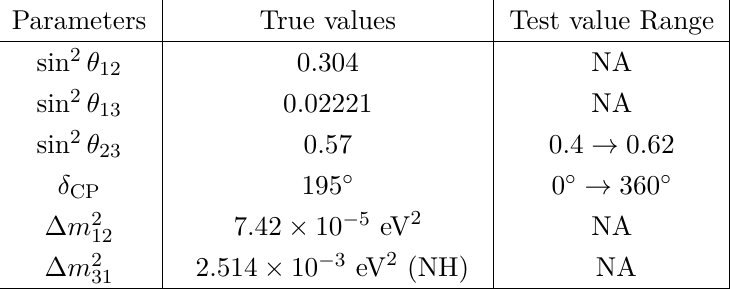
Table 2 . The values of oscillation parameters that we considered in our analysis. values of θ are adopted from NuFIT [59] and we list them in table 2. We marginalize the 23 phase δ in the full range. We have also marginalized sin 2 θ CP table. We have kept the rest of the parameters fixed in both true and test spectra of the χ 2 . We show all our results for the normal hierarchy of the neutrino